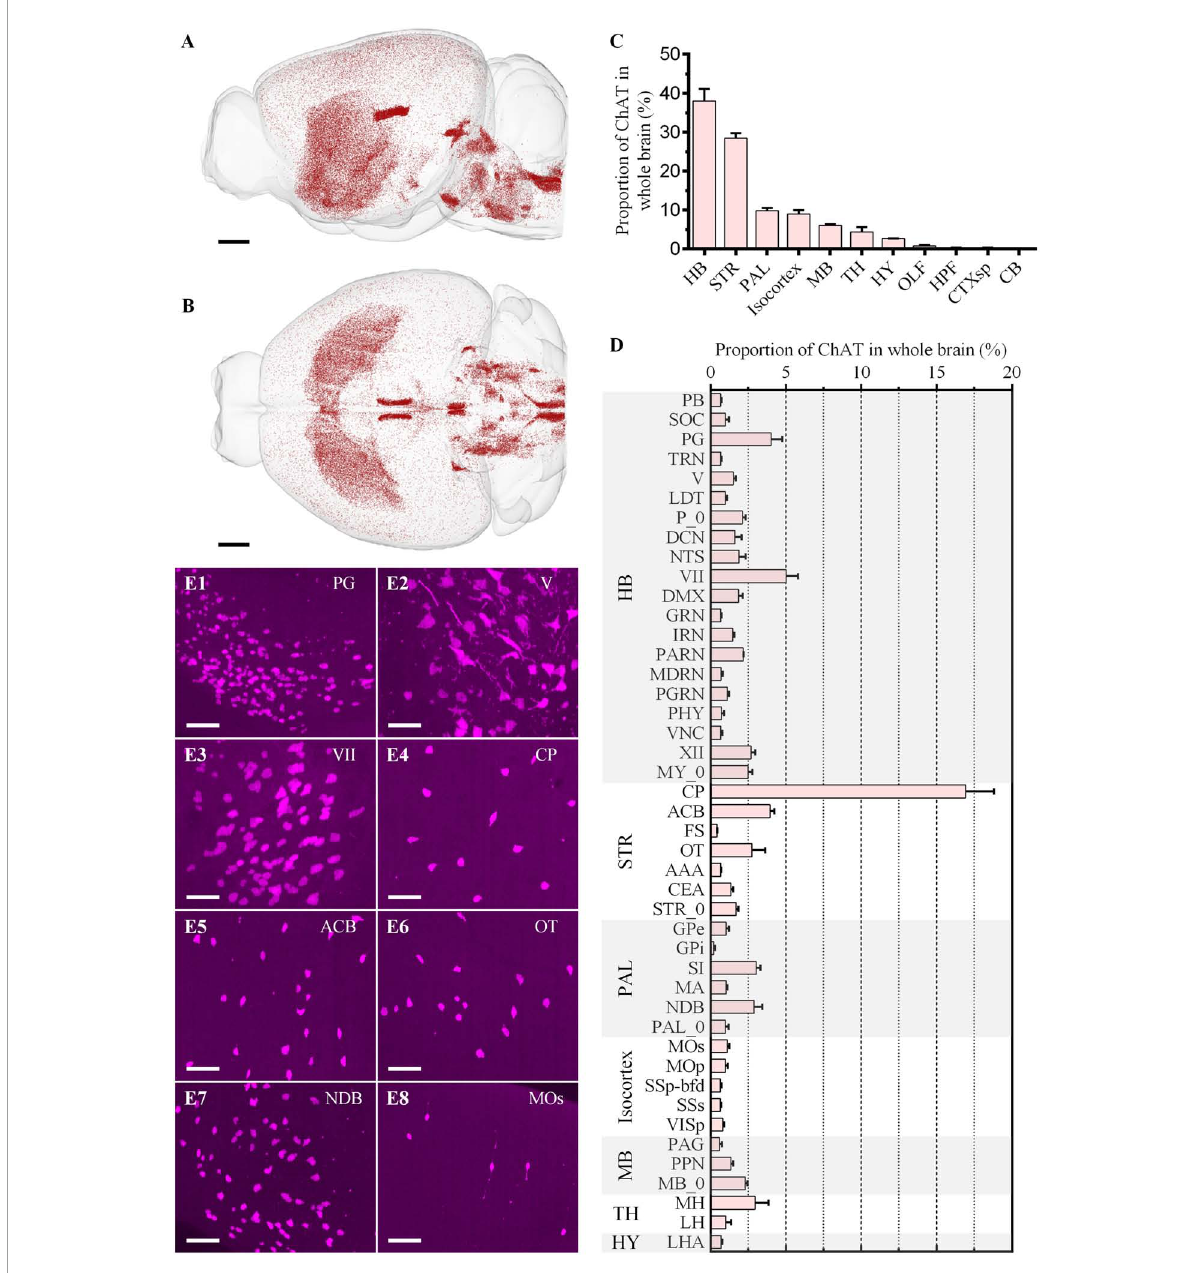
FIGURE5 Whole-brain quantitative statistics of the cholinergic neurons in the red channel. (A,B) Whole-brain distribution of cholinergic neurons in the sagittal view (A) and horizontal view (B) . (C,D) The proportion of the cholinergic neurons in brain regions (C) and brain sub-regions (D) . Data is shown as mean ± s.e.m ( n = 4 mice). (E1–E8) Signal distribution in PG, V, VII, CP, ACB, OT, NDB, and Mos, respectively. The projection thickness of the images: (E1–E8) 50 µ m. Scale bars: (A,B) 1 mm, and (E1–E8) 50 µ